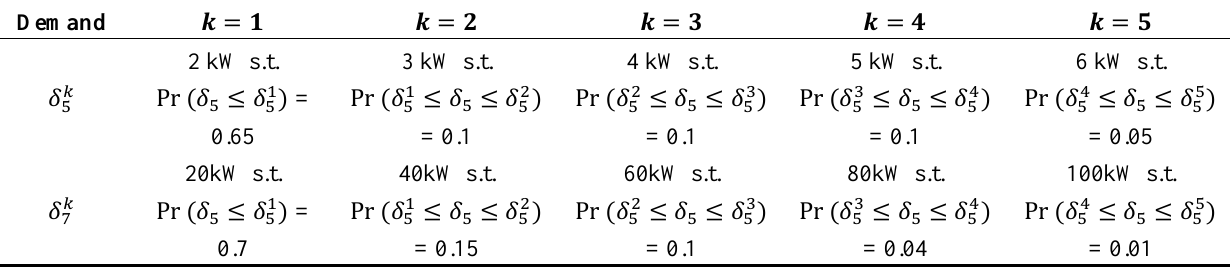
Table 3. 5-bin discretized energy demand distribution for air conditioning